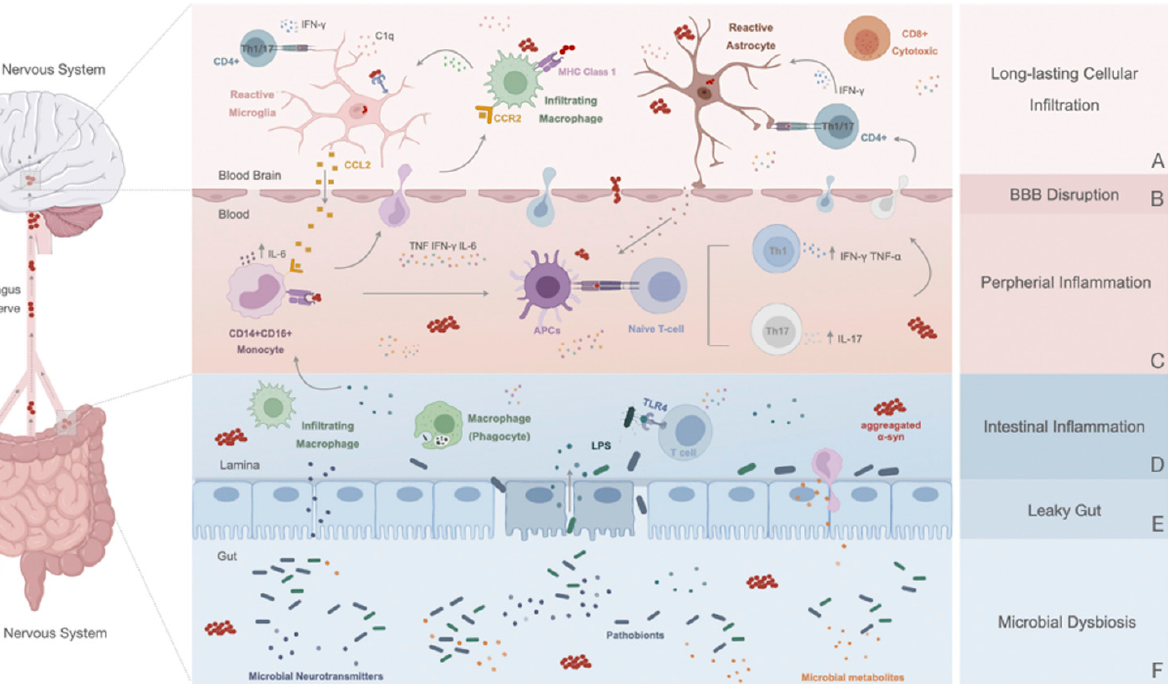
with microglia and astrocyte reactivity), the exposure of the brain to blood-derived substances derived substances occurs, implying a long-lasting infiltration of immune cells, thus reinforcing the